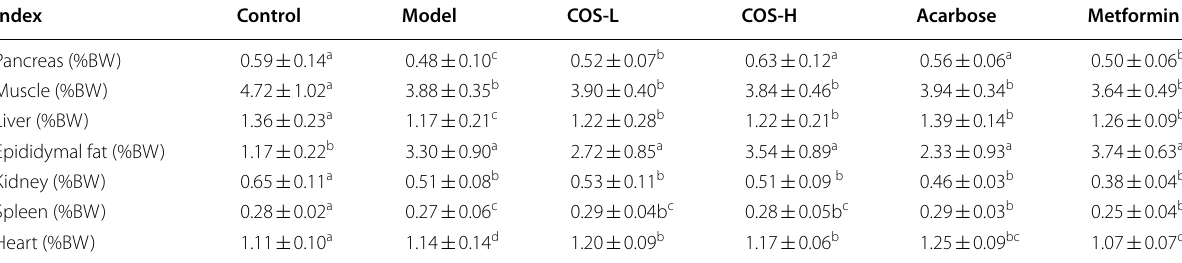
Different letters in the same column represent significant differences between the treatments when p <